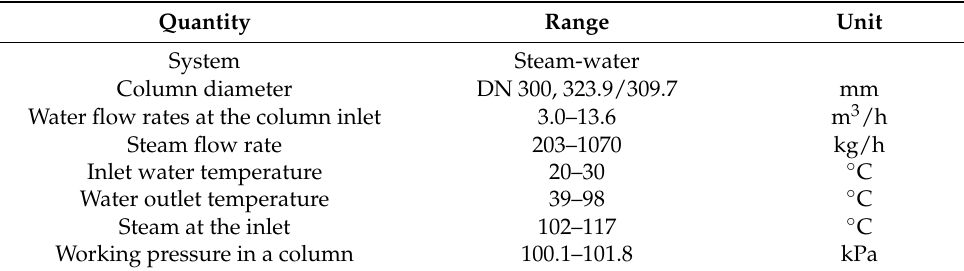
Table 9. The test conditions during experiments in the study of Genic [45].